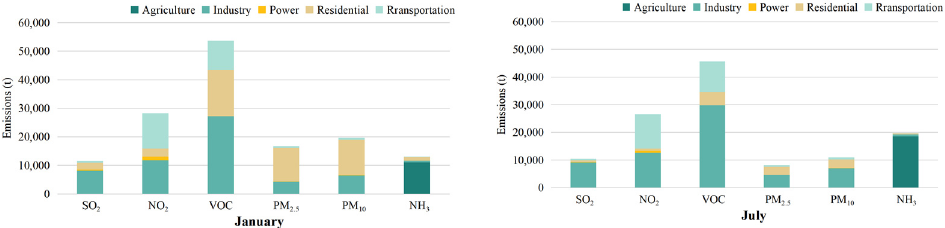
Figure 5. Emission of pollutants in agriculture, industry, power, residential and transportation sec-